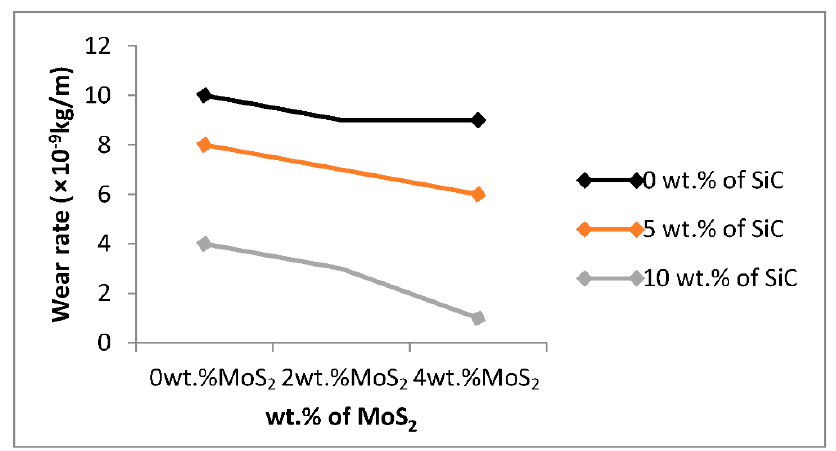
Figure 7. Effect of process parameters on wear rate.